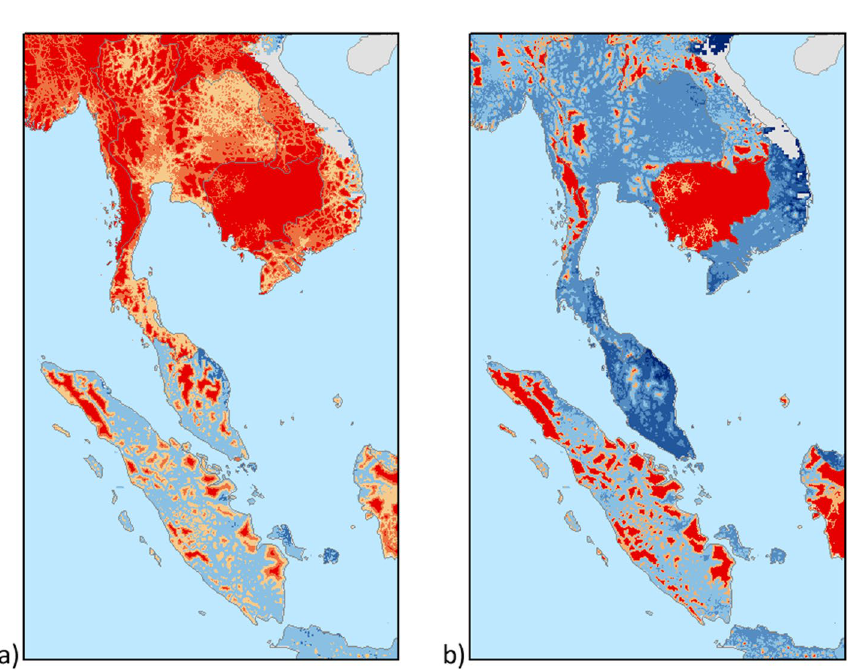
Figure 3. Competitiveness of PV-based (red) and diesel based (blue) minigrids in the Indochinese peninsula under ( a ) favourable and ( b ) adverse scenarios for PV. Red-coloured areas are those in which PV minigrids are cheaper. Blue-coloured areas are those in which diesel-based minigrids are cheaper. The higher the contrast, the larger the difference in cost estimates. ArcGIS 10.6 (https ://deskt op.arcgi s.com/) was used to calculate the values and generate the map. GIMP 2.10 (https ://www.gimp.org) was used for image